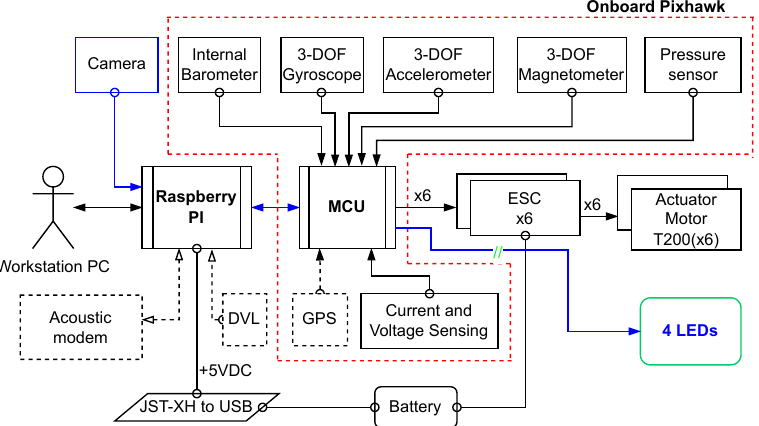
Figure 6. Architecture of the electronic components of the BlueROV underwater robot with the addition of four